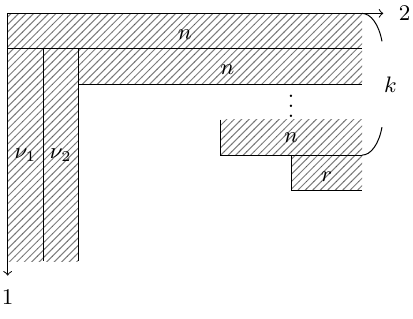
Figure 9 . k (cid:21) 0 case. We denote the height to x 3 direction by the number written in each